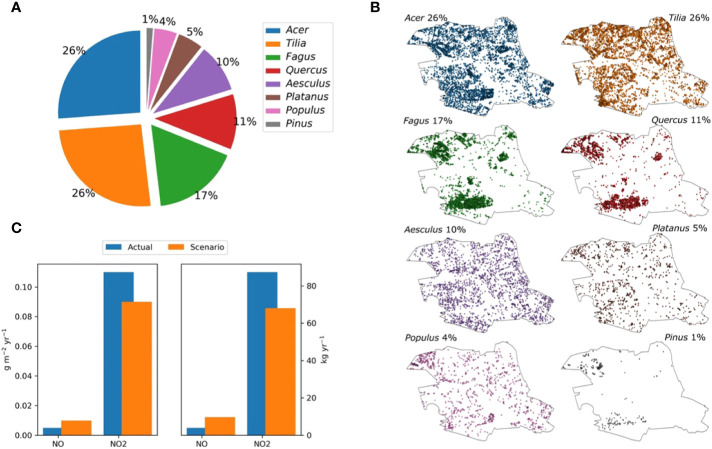
Tree population in Central Berlin and modeling of NOx deposition. The calculations are done with NO2 and NO concentrations of the year 2014 for the central district of Berlin (Mitte). This area hosts about 78,000 trees with the species composition indicated in (A) and the spatial distribution depicted in (B). The overall annual deposition of NO2 and NO per m2 regarding this species composition (standard) and alternative species composition (scenario) is shown in (C). For the scenario, the four urban climate-resilient tree-species (Carpinus betulus, Fraxinus ornus, Fraxinus pennsylvanica, Ostrya carpinifolia) replaced the four actual dominant tree genera as indicated by the senate of Berlin. For parameterization, we assume that the genera can be characterized by the most abundant species in each genera group (Acer platanoides, Tilia cordata, Fagus sylvatica, Quercus robur, Aesculus hypocastanum, Platanus hispanica, Populus nigra/alba, and Pinus sylvestris).